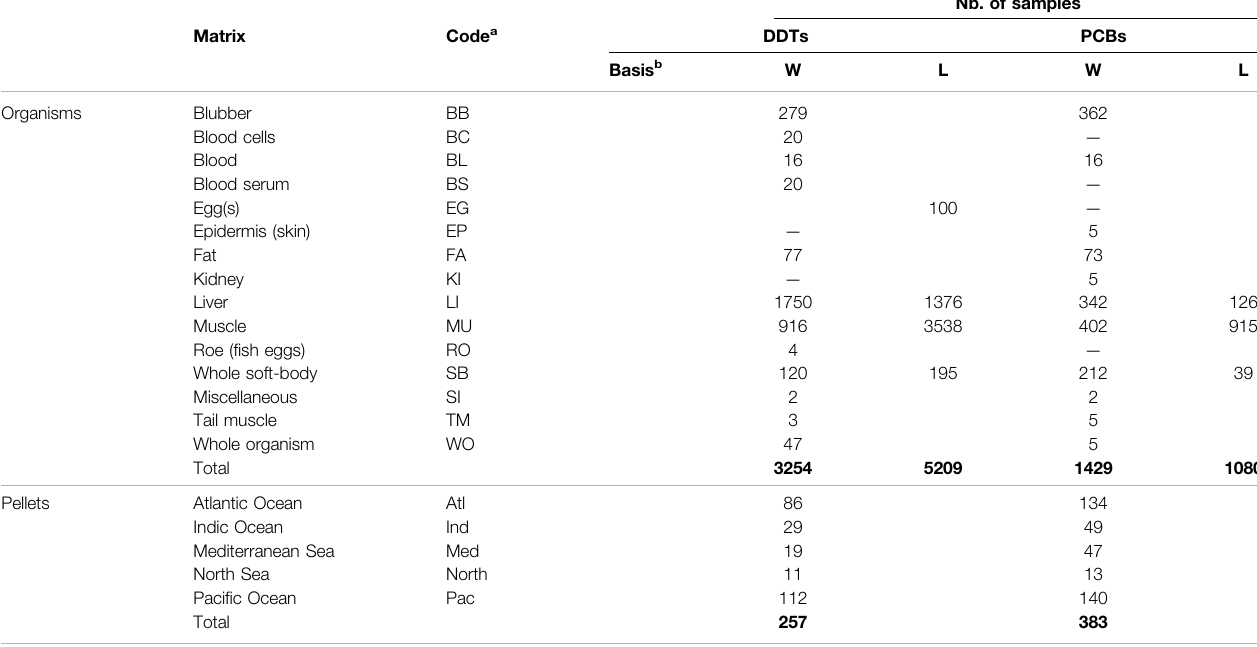
TABLE 1 | DDT samples in different matrices in organisms and plastic pellets.